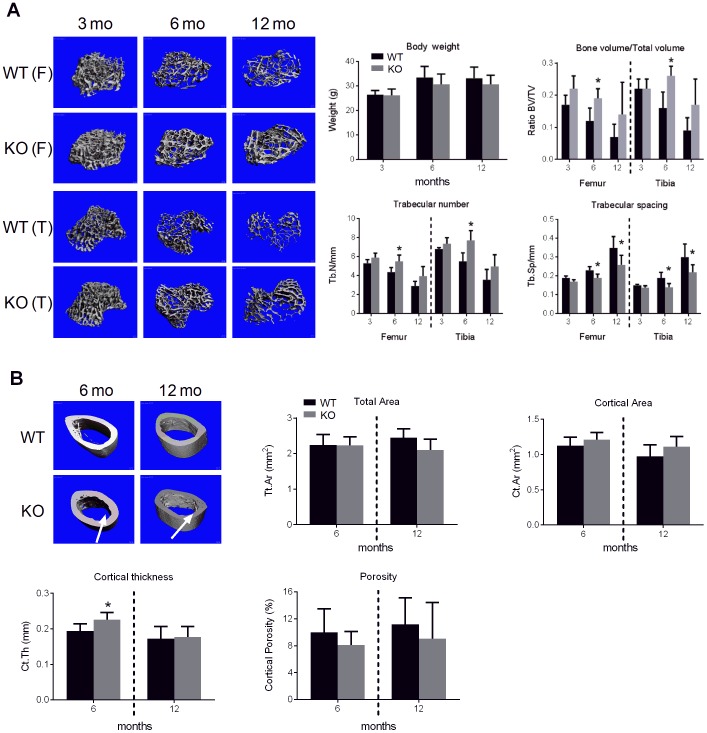

Spon1
−/− mice have increased trabecular and cortical bone.(A) Representative 3D µCT images showing regions of trabecular bone in the distal femur (F) and proximal tibia (T). Graphs represent measurements of total body weight (g), trabecular bone volume (bone volume per tissue volume, BV/TV), trabecular number (Tb.N/mm) and trabecular spacing (Tb.sp/mm) in the femurs and tibiae of 3 month (n = 4), 6 month (n = 10–11) and 12 month (n = 6) -old Spon1
−
/− and WT mice. (B) Representative 3D µCT images showing regions of femoral cortical bone in WT and Spon1
−
/− mice. Graph represents measurement of total area (Tt.Ar mm2), cortical area (Ct.Ar mm2, cortical thickness (Ct.Th/mm) and intracortical porosity (%) of 6 month (n = 6–11) and 12 month (n = 5) mice. Arrows show the irregular surfaces along the endosteal perimeters of Spon1
−
/− mice. Statistically significant differences from WT mice groups are indicated by *(P<0.05).